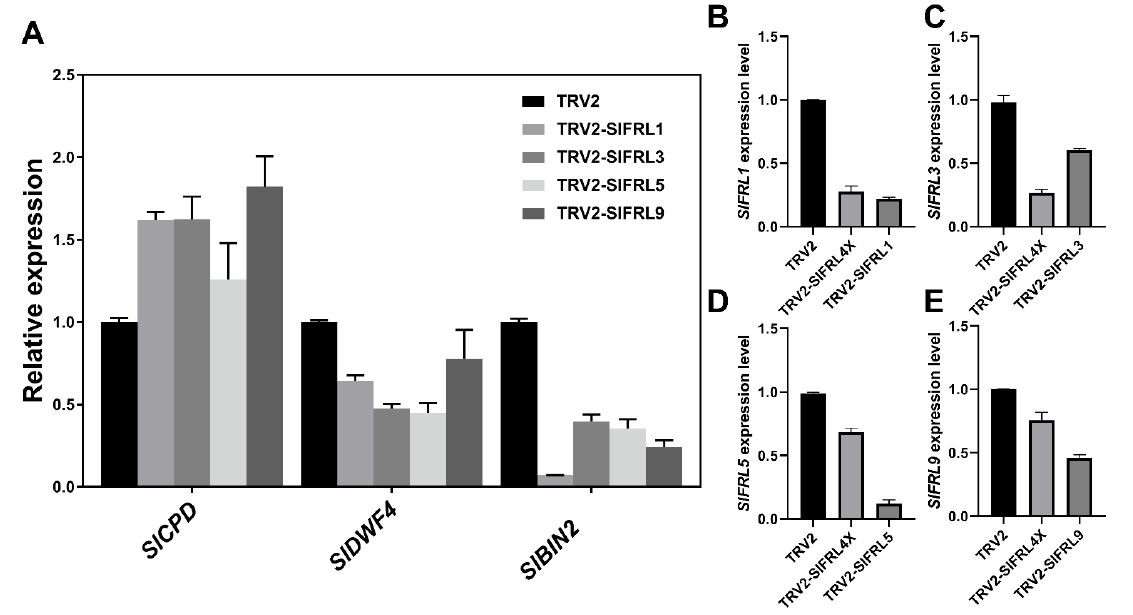
Figure 10. Expression levels of genes after instantaneous silencing of SlFRLs. ( A ) was identification of mRNA levels of multiple genes in transient silencing materials, and ( B – E ) were identification of mRNA levels of silencing materials. SlUBI3 was used as the internal reference gene, repeated three times and calculated by 2 −ΔΔ CT .